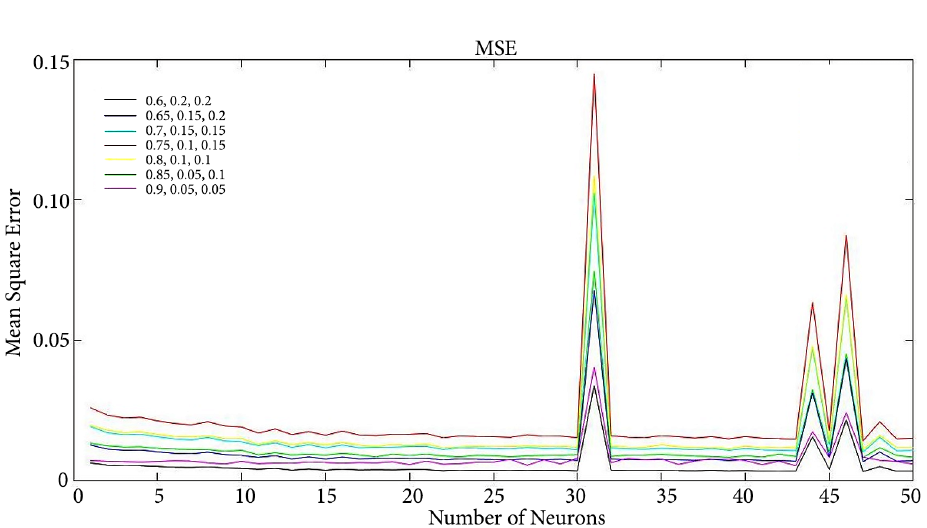
Figure 4. MSE Results of all datasets under ANN using FF5C